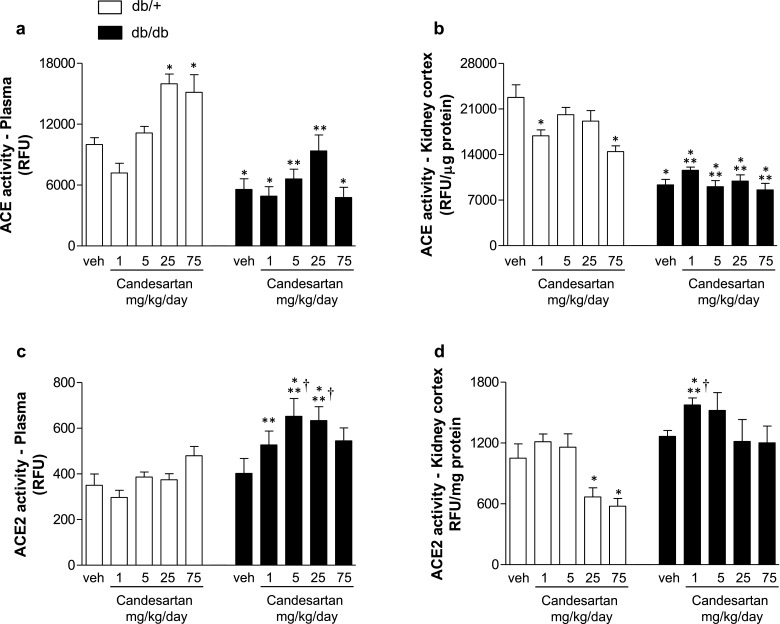
Intermediate dose of candesartan increases renal activity of ACE2, but not ACE, in db/db miceEnzymatic activity of ACE (a, b) and ACE2 (c, d) in plasma and kidney cortex from db/+ and db/db mice treated with vehicle or candesartan (1, 5, 25 or 75 mg/kg/d). Results are presented as mean ± S.E.M. of 5–7 mice. *P<0.05 compared with vehicle-treated db/+; **P<0.05 db/db compared with db/+ of corresponding candesartan dose; †P<0.05 candesartan-treated db/db compared with vehicle-treated db/db.